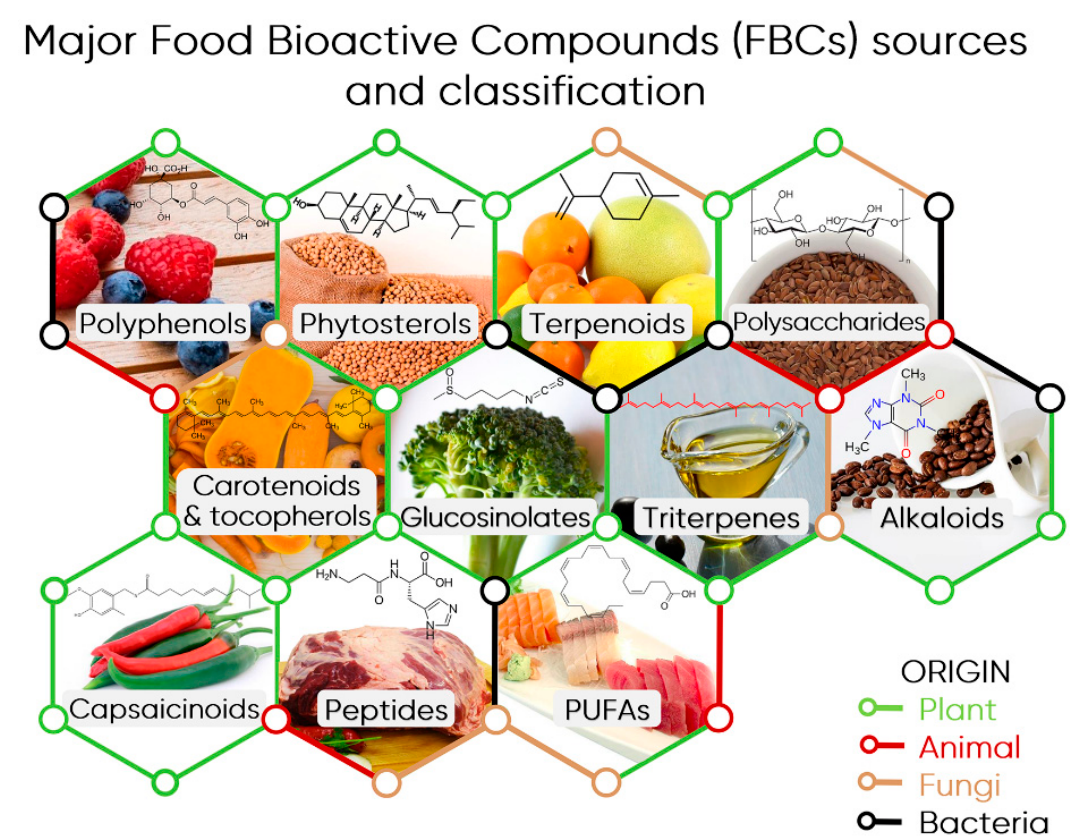
Figure 4. The various classes of major bioactive compounds found in food products. Reproduced from Câmara et al. [63] under Creative Commons 4.0